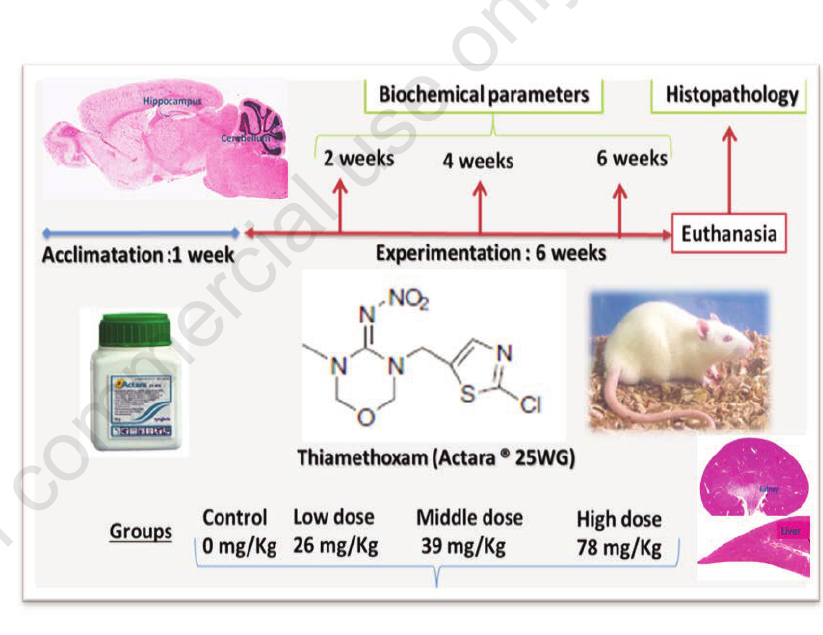
Figure 1. Experimental animals and research design.